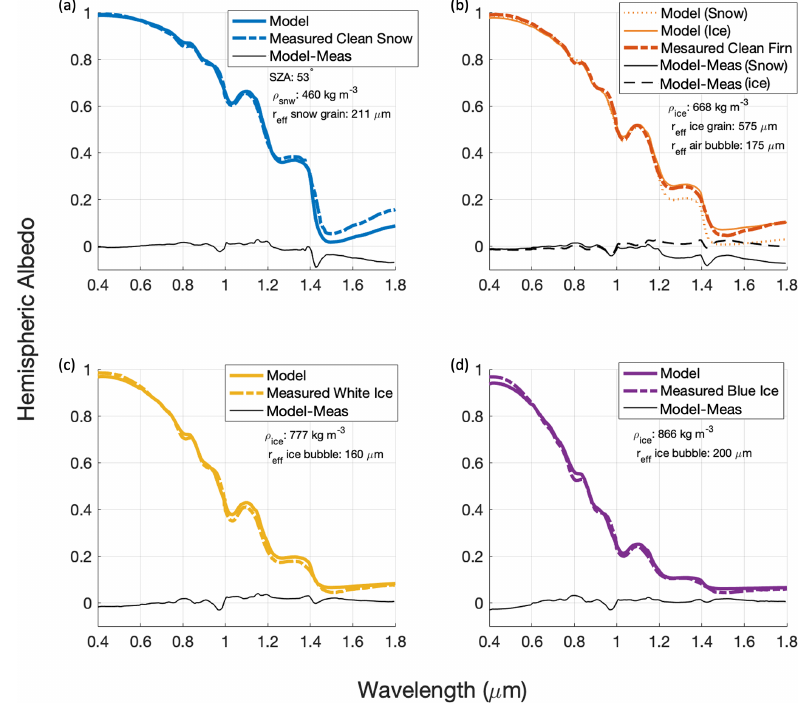
Figure 11. Spectral albedo measured by Dadic et al. (2013a) compared to SNICAR-ADv4 modeled spectral albedo. The model parameters are tightly constrained with quantitative measurements made by Dadic et al.